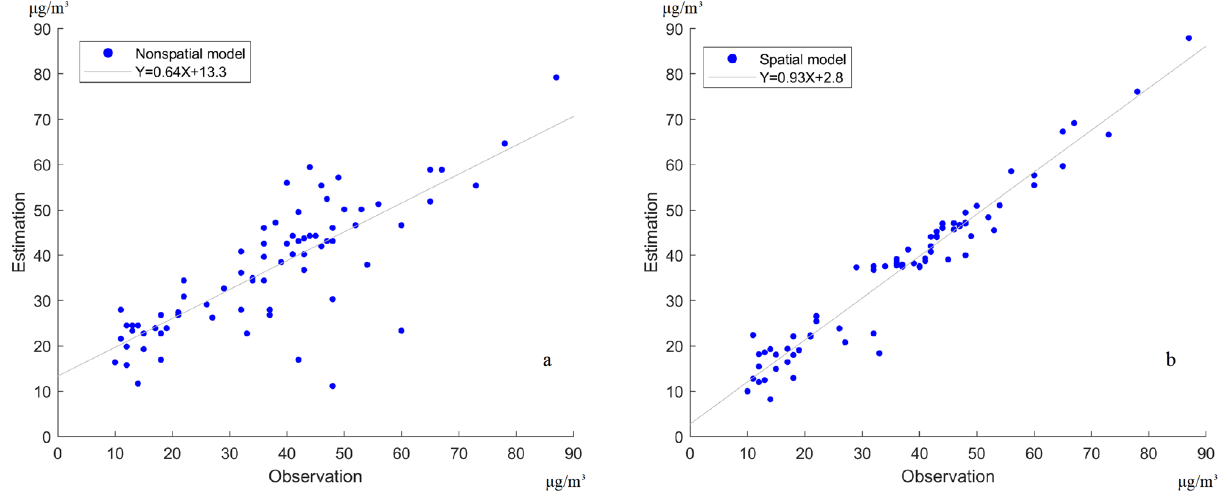
Figure 4. Calibrated results (estimations) when compared to observations in the ( a ) nonspatial and ( b ) spatial calibration models (slope: 0.64 and 0.93; intercept: 13.3 and 2.8 in the nonspatial and spatial calibrations, respectively).